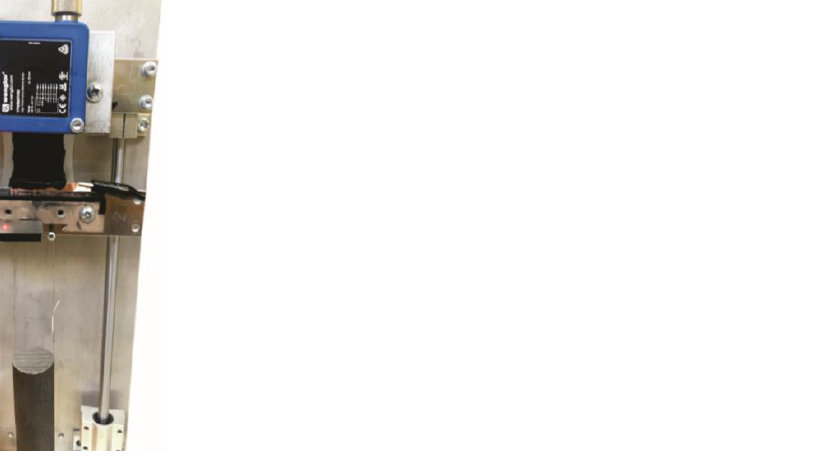
Figure 10. Experimental setup of the real DEA or the plant model for simulations.